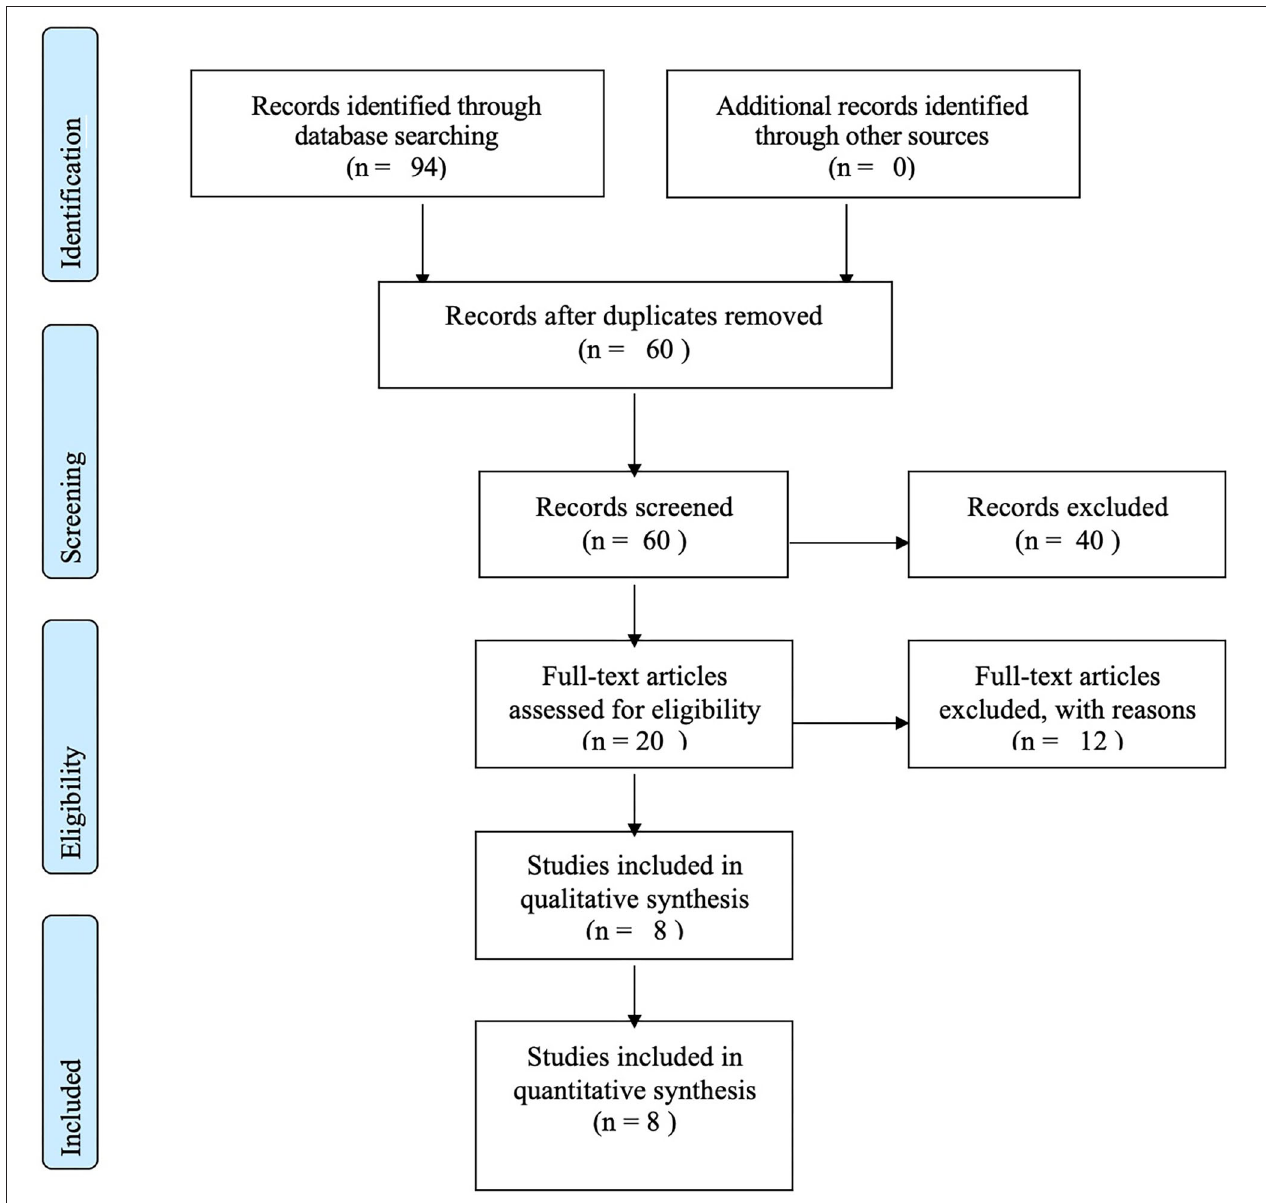
FIGURE 1 | Prisma flow